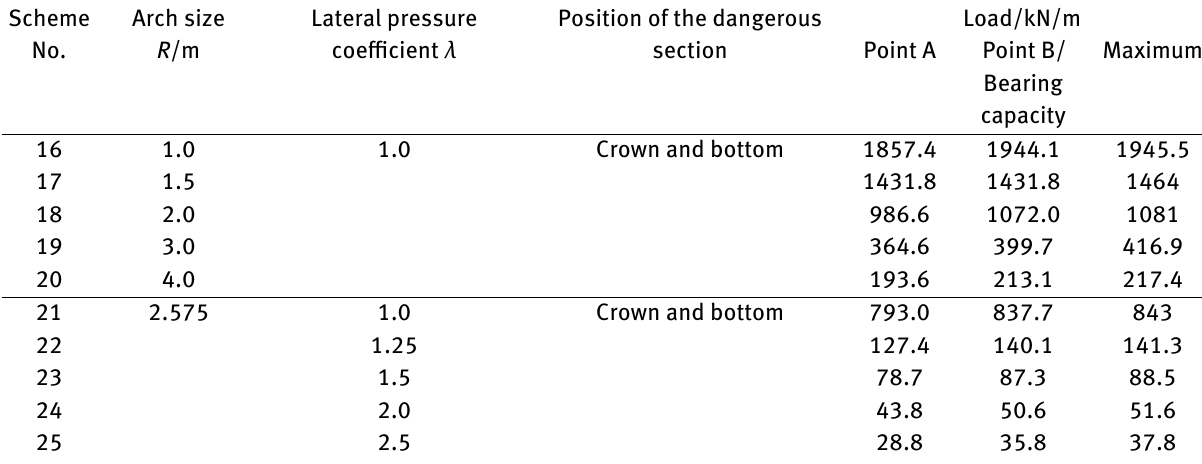
Table 3: Numerical simulation results for Schemes 16–25 Scheme Arch